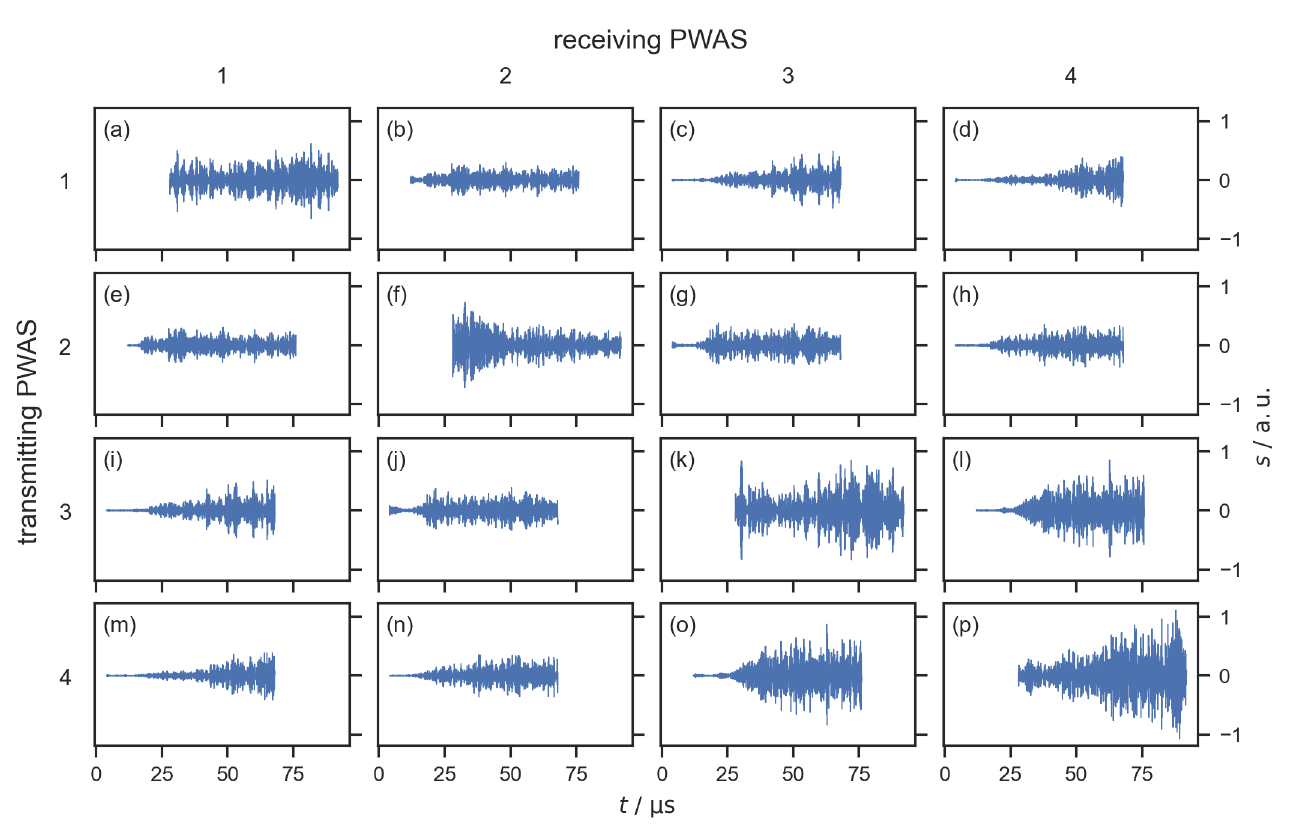
Figure 5. Difference signals within the ROI for all signal paths. ( a , f , k , p ) Echo signals that are transmitted and received by the same PWAS. ( b , e , l , o ) Signal paths across the flow field. The remaining difference signals are for diagonal signal paths. The difference signal shown in ( b ) is the same signal that is shown in Figure 4c. For the water detection and localization, signals shown in ( e , i , j , m – o ) are disregarded since they are almost identical to signals shown in ( b – d , g , h , l ),